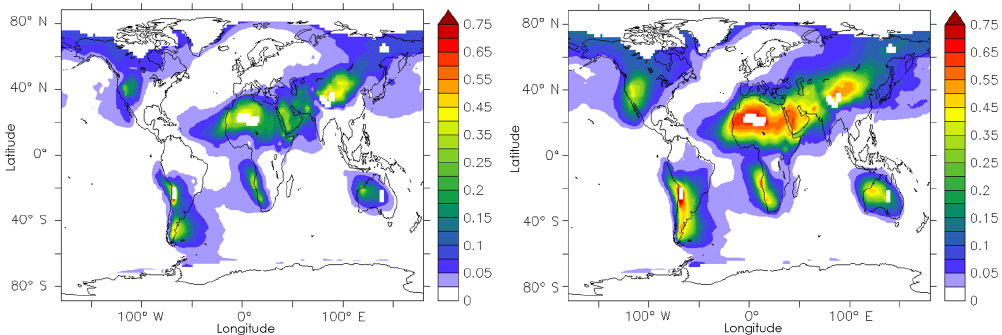
Figure 3. Predicted annual mean insoluble fraction of aerosols in the (a) accumulation and (b) coarse modes at the lowest cloud-forming level